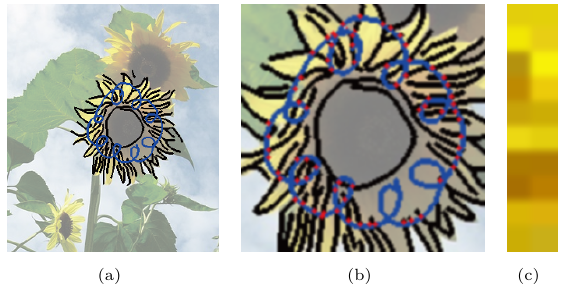
Fig. 7 Evidence collection. (a) Blue scribble: input structure stroke, black lines: candidate line segments. (b) Close-up; red dots: intersections of user strokes and candidate line segments. (c) 10 pairs of means, out of 67 in total, illustrate examples of evidence. Fig. 8 Structure line matching with different proportions of line segments. (a) Input image and structure strokes. (b) Detailed line v . The operator ∆ E ∗ represents the CIE94 color i 94 drawings using fDoG [2]. (c)–(e) Line segments with costs less than one, two, or three standard deviations